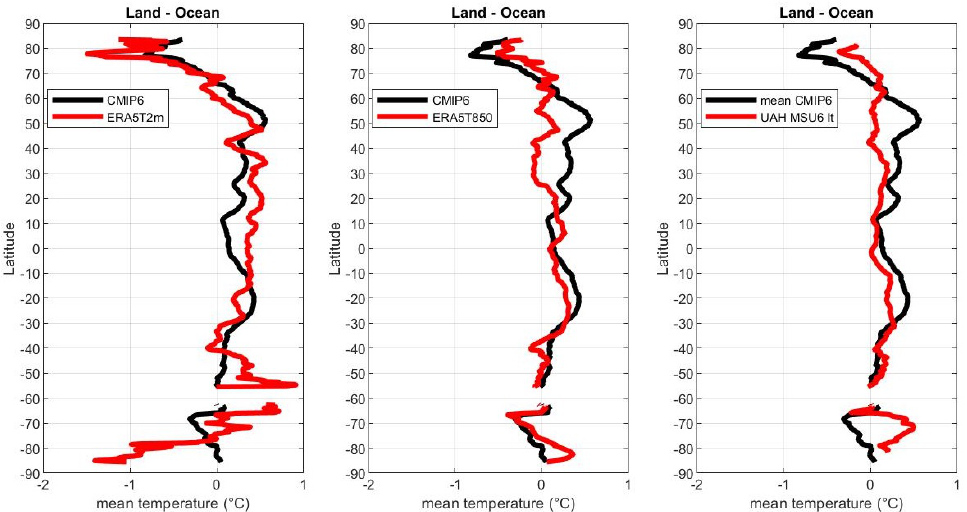
Figure 4. Comparison between the CMIP6 ensemble mean and the temperature records (ERA5-T2m, ERA5-850mb, and UAH MSU v6.0 Tlt) using the latitudinal profile of the difference between land and ocean